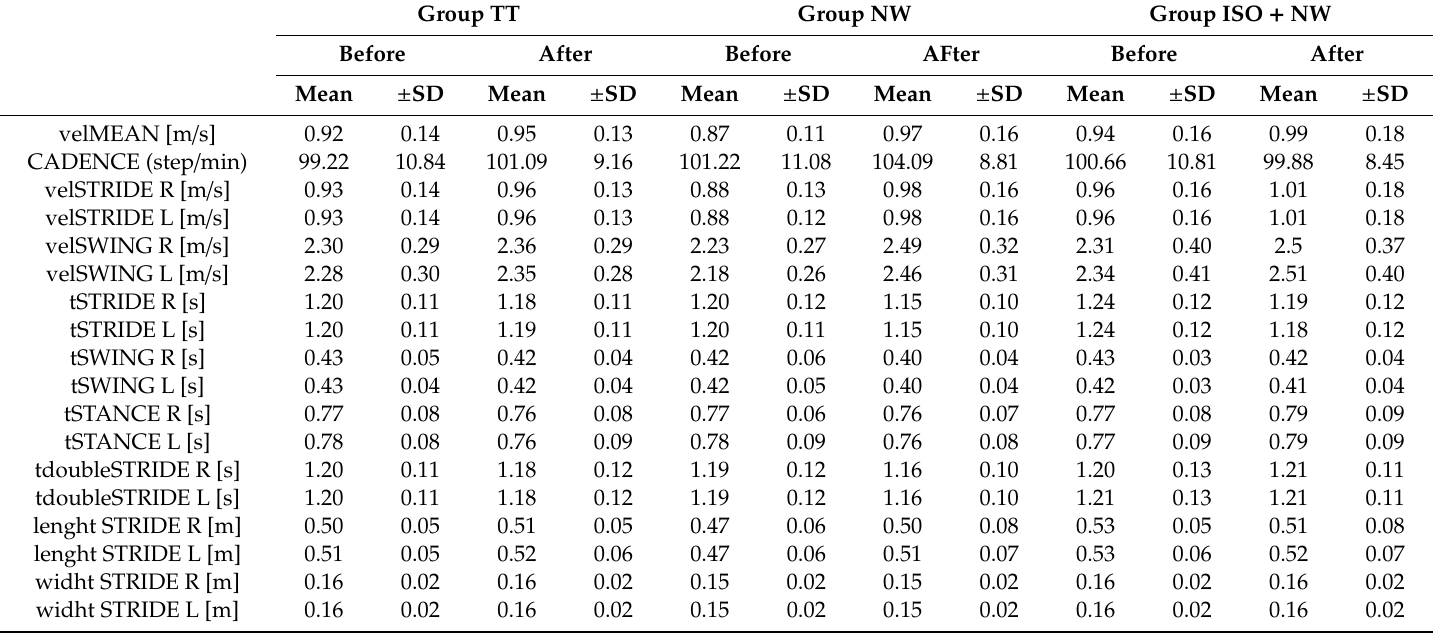
Table 3. The values of the spatiotemporal parameters of gait recorded in each group of subjects before and after 3-month training program. Group TT Group NW Group ISO + NW Before Before AFter Before